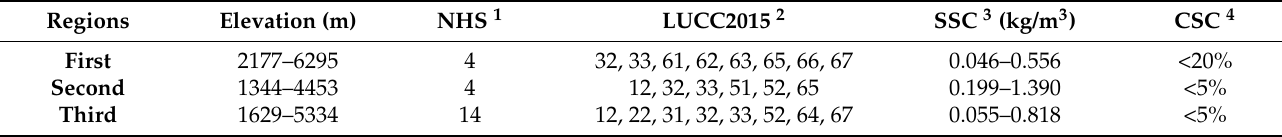
Table 1. Underlying surface types and water suspended sediment concentrations of the three